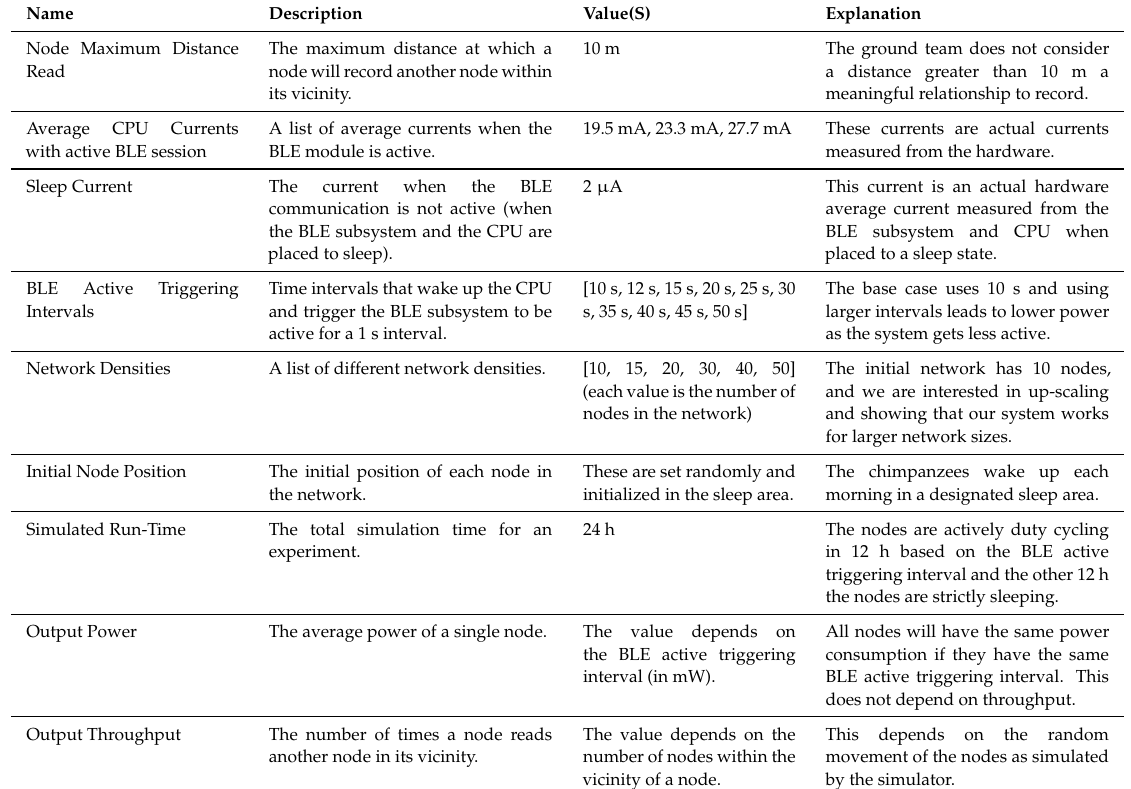
Table 6. Significant simulator